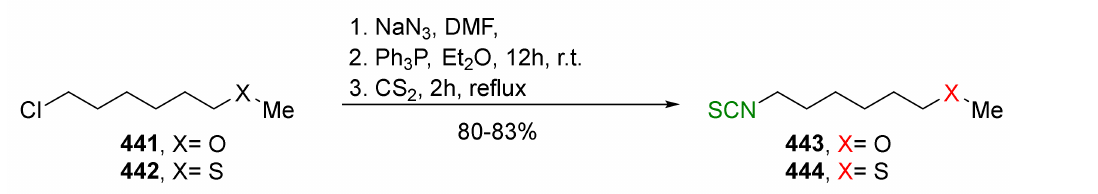
Figure 48. Synthesis of analogues of 6-MITC: ITCs 436 – 440 .